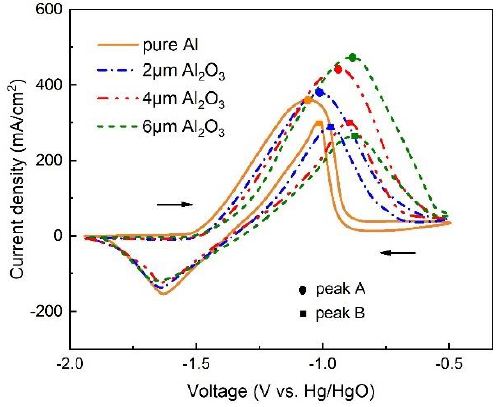
Figure 4. Cyclic voltammogram of Al anode without and with different thicknesses of Al 2 O 3 films in 4 M KOH.